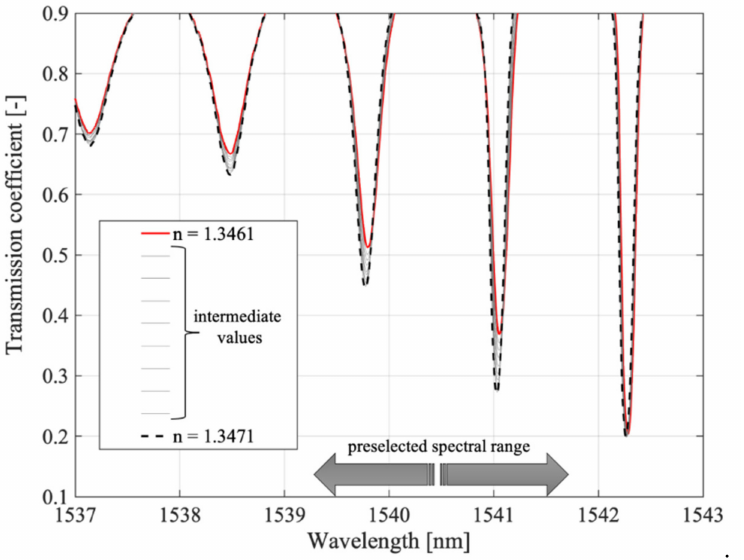
Figure 19. Results of the spectral measurements for modal preselection P-TFBG 7 ◦ . Measurements were made in the range of changes RI =